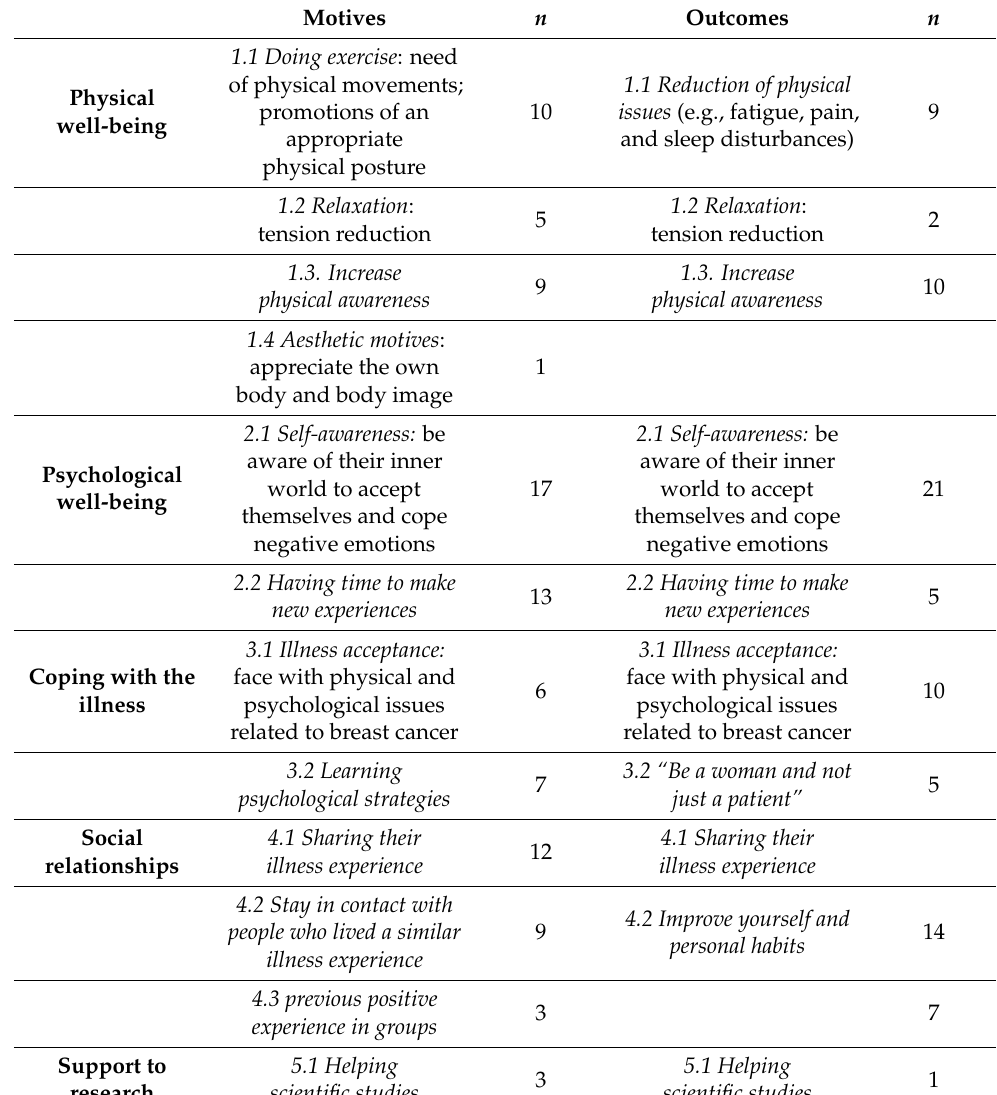
Table 2. Participants’ motives and outcomes related to the intervention. Motives